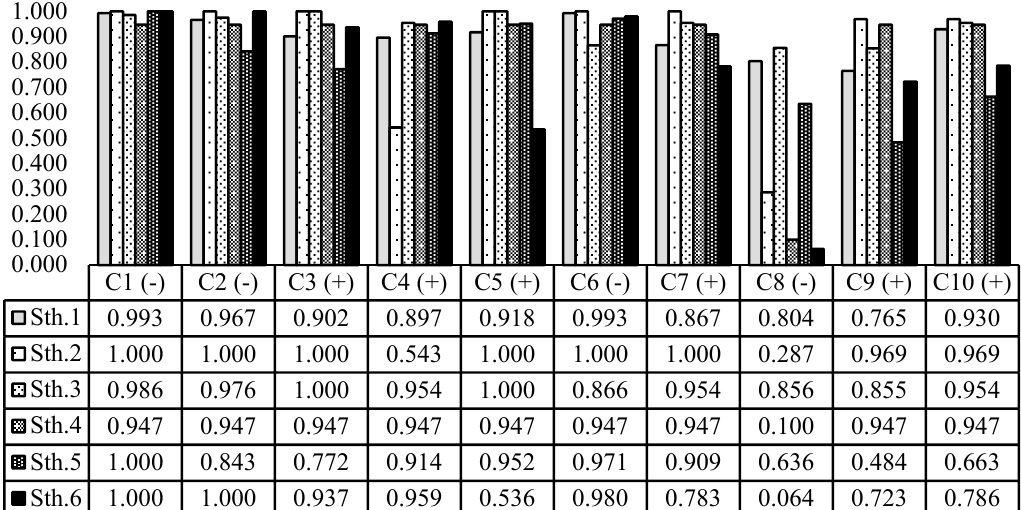
Figure 7. Water 2020 , 12 , x FOR PEER REVIEW